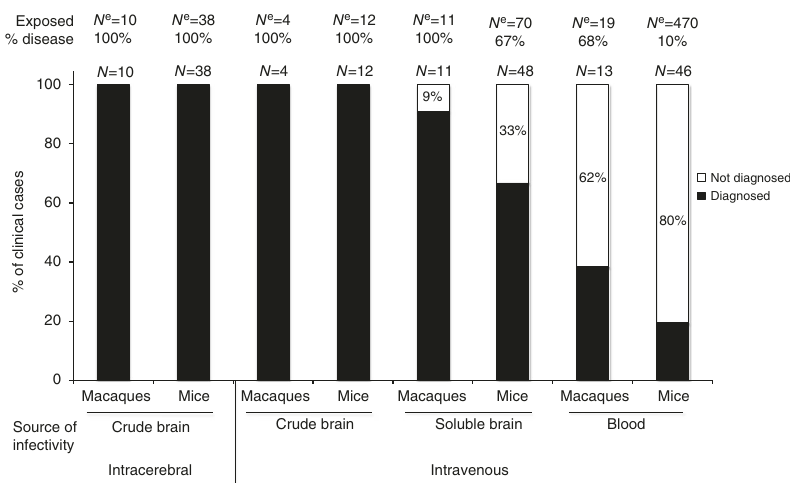
Fig. 1 Ability of current diagnostic criteria to identify the disorders as prion diseases as observed in the different models used in this study. We considered here that the diagnosis of prion disease is based on the presence of PK-resistant abnormal PrP in the brains of animals with possible prion disease. For each model, N e corresponds to the number of animals exposed to the sources of infectivity and N to the number of mice developing neurological impairments (% disease = N / N e × 100). The numbers within bars correspond to the percentages of neurologically affected animals without detectable PrP